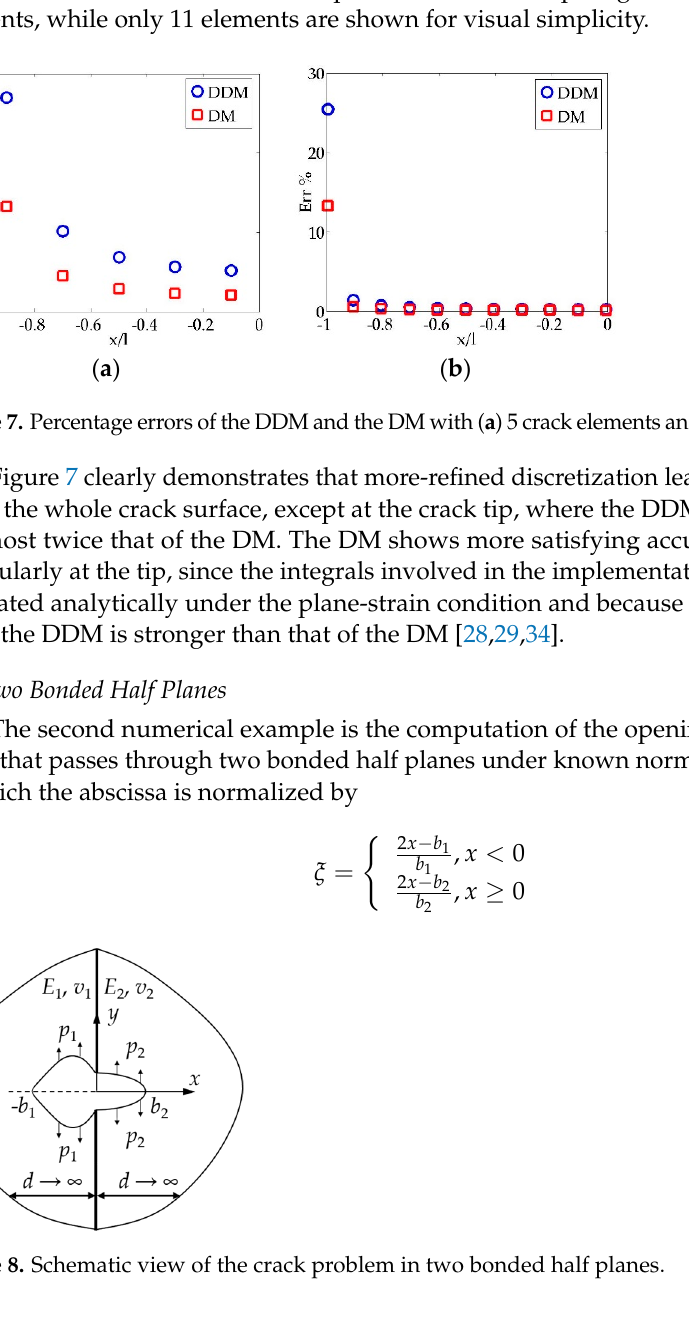
Figure 8. Schematic view of the crack problem in two bonded half planes. In addition, the two half planes are characterized by E 1 , v 1 and E 2 , v 2 , respectively. We set E 1 = 3.07(GPa), v 1 = 0.35; E 2 = 68.95(Gpa), and v 2 = 0.3 and present the percentage errors of the DDM and the consecutive stiffness method (CSM) with respect to the semi-analyt- ical solution in Figure 9 with different b 1 / b 2 values. The thickness of layer d is set to be